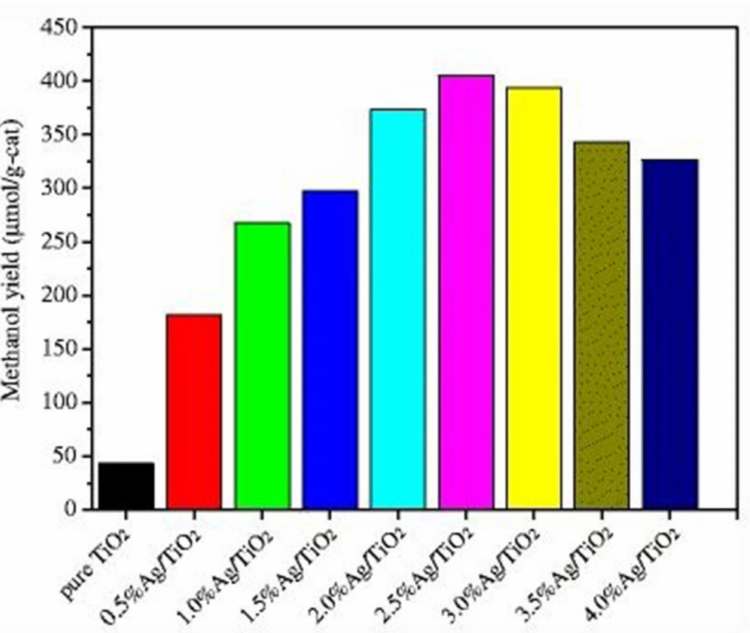
Figure 16. Ag/TiO 2 -based photocatalysts for reduction of CO 2 , with different samples showing higher methanol yield than pure TiO 2 . Reprinted with permission from Springer Nature, 21 December 2021 Ref.